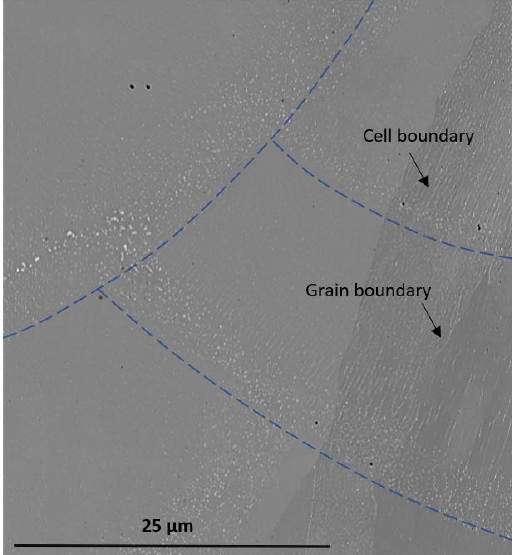
Figure 8. SEM micrographs of as-built PBF-LB processed Al-Mn-Cr-Zr. Melt pool boundaries marked in blue.